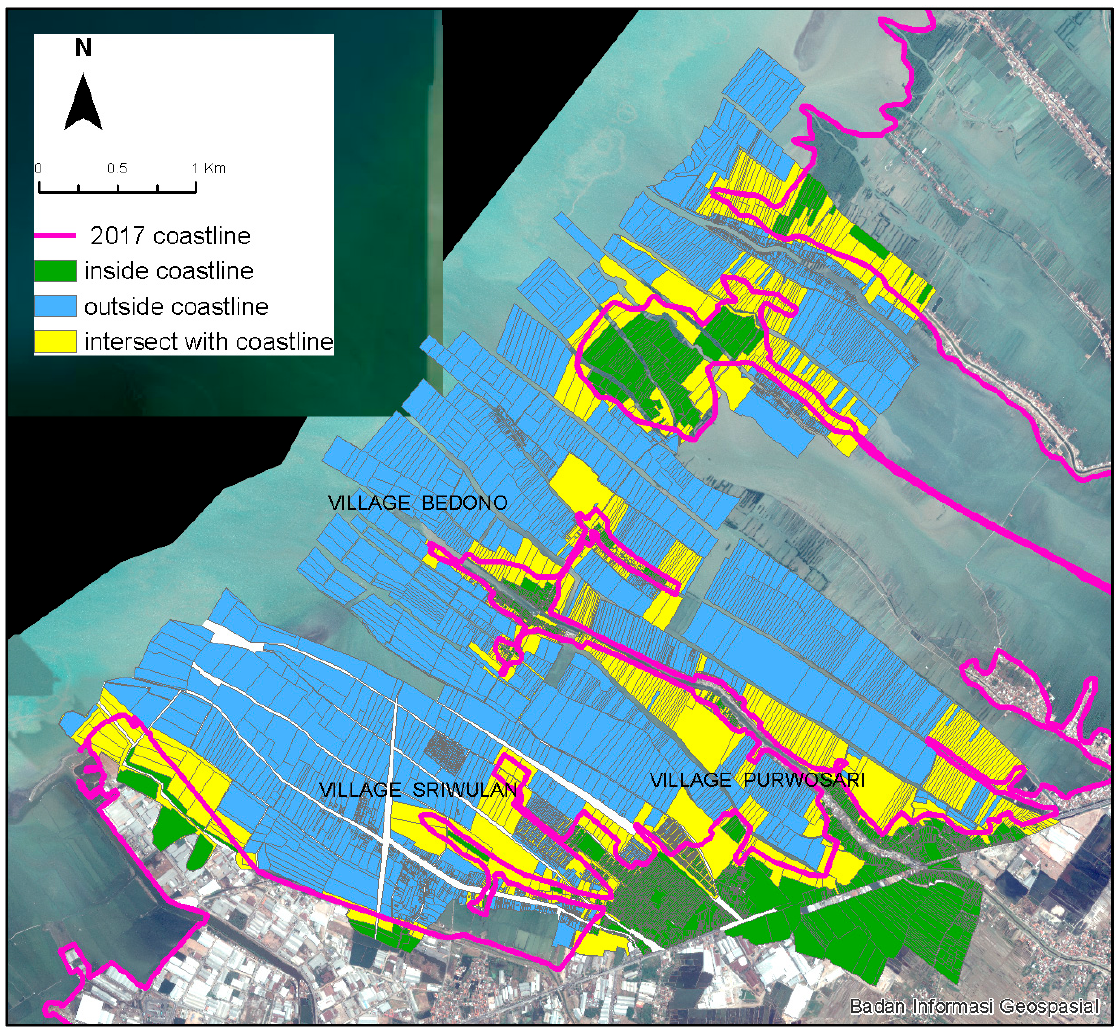
Figure 3. Land parcel from taxation map overlaid with 2017 coastline. The 2017 coastline was accessed from the Ministry of Marine and Fisheries, while the taxation map was accessed from Local Land Office in Kabupaten Demak. The blue figure shows land parcel located outside the coastal area, while the yellow parcel depicts land parcel that intersect with the coastline, and the green parcels located inside the coastline.